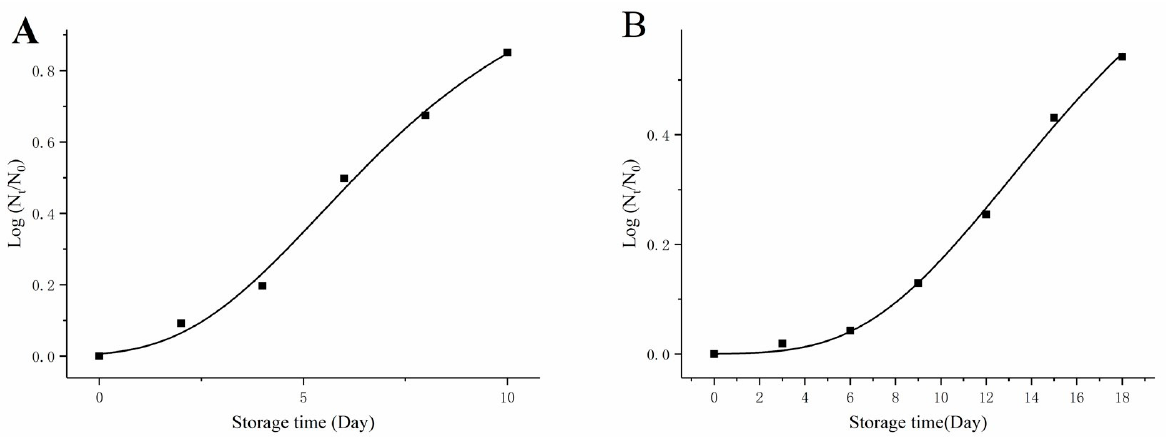
Figure 5. Changes in the number of colonies in HHP-WP during storage at 25 °C ( A ) and 4 °C ( B ). The scatter plots represent the number of colonies at different times, and the curve represents the fitting of the SGompertz model.